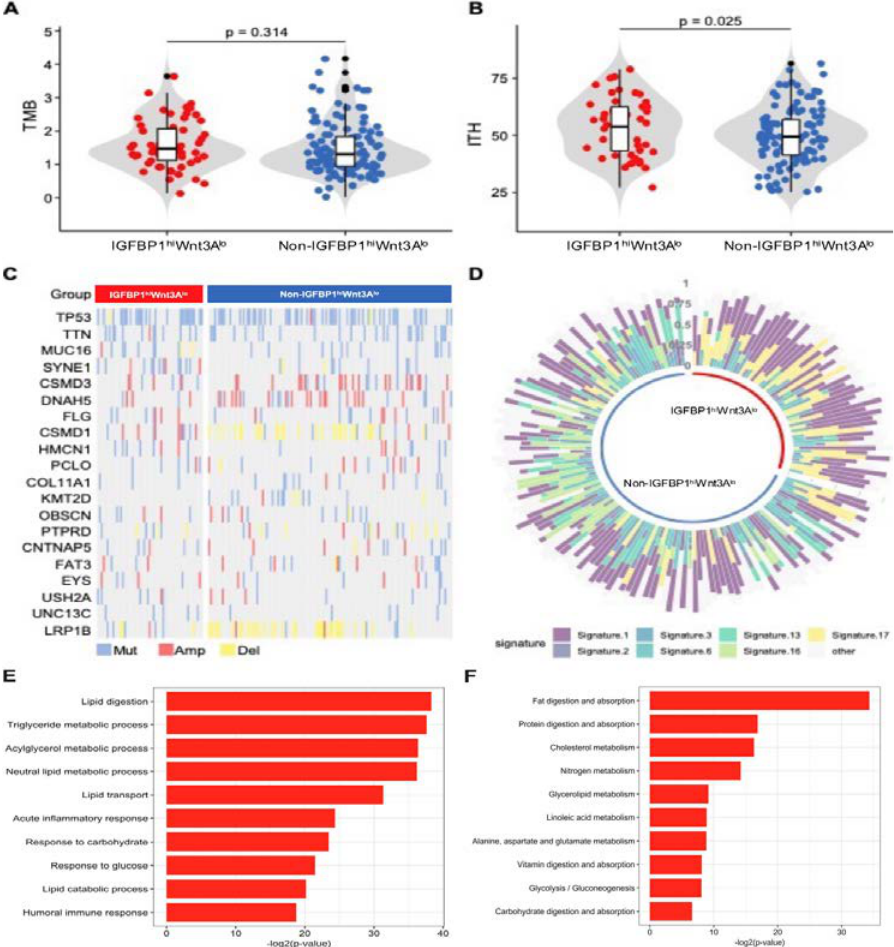
Figure 3. Molecular characterization of subtypes. ( A , B ) Violin plots illustrating TMB and ITH differences between subtypes in the cohort from TCGA; ( C ) comparison of mutated genes between subtypes sorted by mutation frequency; ( D ) mutation characteristics between subtypes in the cohort from TCGA; ( E , F ) GO and KEGG analyses used significantly upregulated differential expression genes. The results revealed activation of immune-related pathways and imbalance of energy metabolism in the IGFBP1 hi WNT3A lo subtype.